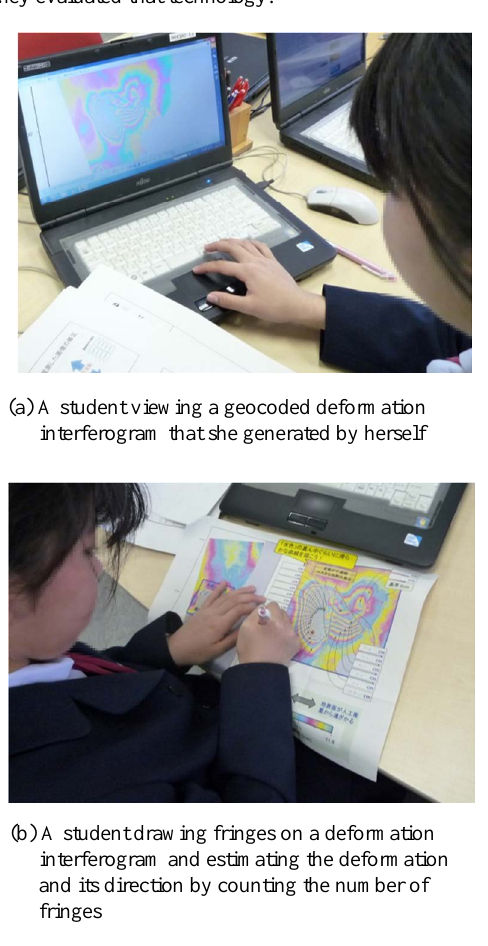
Figure 1. Learning activities in the experimental